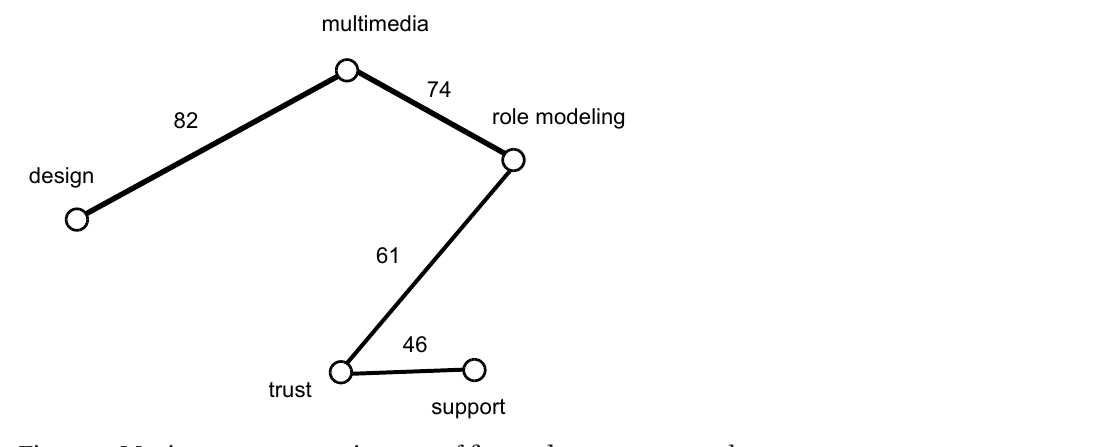
Figure 5 . Maximum cost spanning tree of first order category